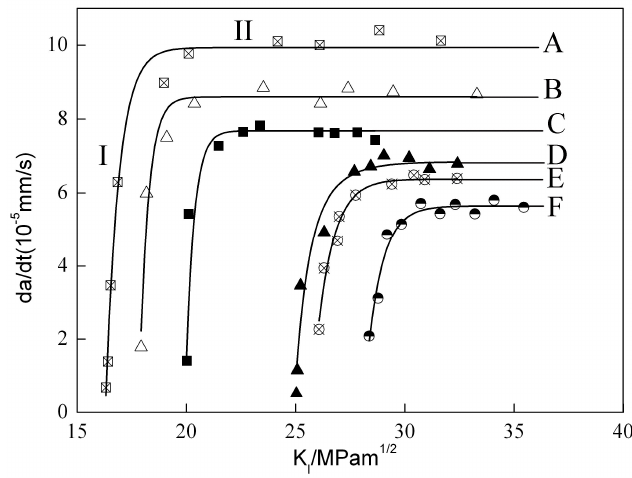
Figure 4. Curves of da/dt vs. K I in 7050 aluminum alloy: ( A ) under aged, E = − 1100 mV; ( B ) peak aged, E = − 1100 mV; ( C ) under aged; ( D ) peak aged; ( E ) over aged, E = − 1100 mV; ( F ) over aged. These curves could be divided into two regions, region I and region II. In region I, the crack growth rates of all specimens were highly depended on stress intensity factor while in region II there was no significant correlation between crack growth rate and stress intensity factor [14]. The crack growth rates are calculated by the average crack length recorded everyday through a reading